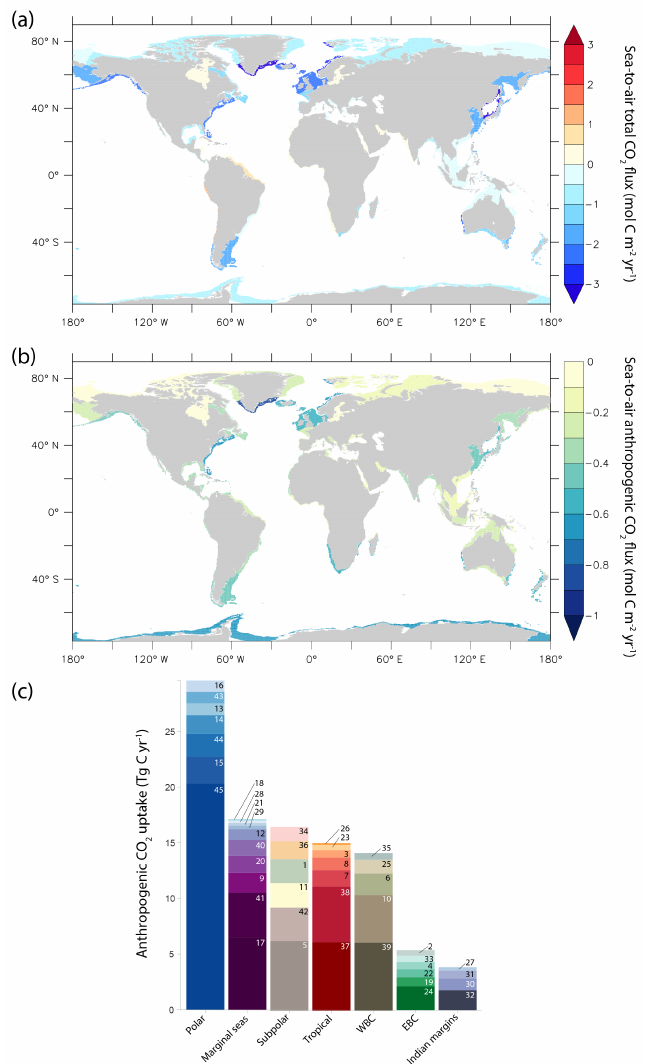
Figure 4. Global mean distribution of the simulated sea-to-air flux of (a) total carbon and (b) anthropogenic carbon over 1993–2012 as molCm − 2 yr − 1 in the global coastal ocean segmented following MARCATS from LA13. (c) Bar chart of the anthropogenic carbon uptake in TgCyr − 1 according to the MARCATS classification. Abbreviations are included for eastern boundary current (EBC) and western boundary current (WBC). Links between numbers and regions are reported in Table 2. Interactive illustrations can be found at http://lsce-datavisgroup.